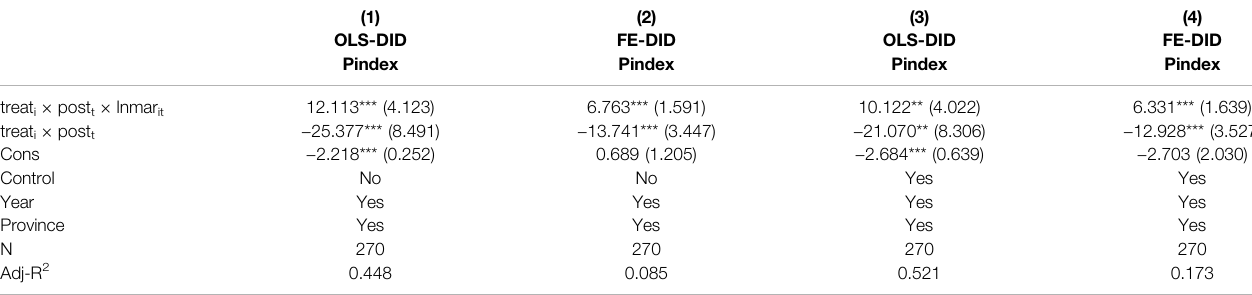
TABLE 6 | Regression results of marketization degree.